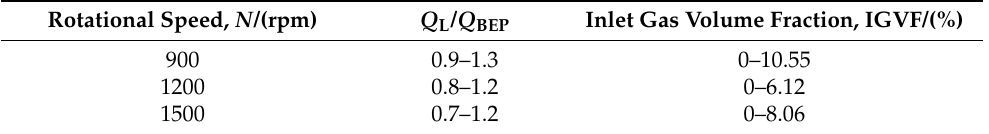
Table 3. Parameters of experimental